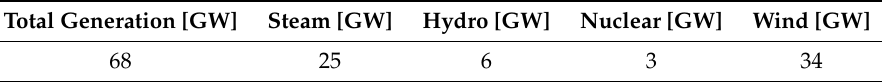
Table 4. Generation distribution for 50% wind power penetration level.